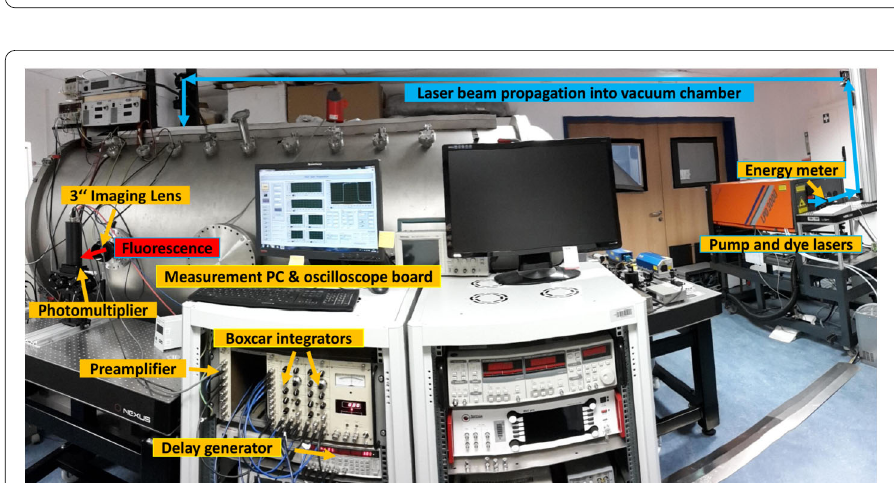
Figure 1 Schematics of the TALIF set-up for ion thruster diagnostics